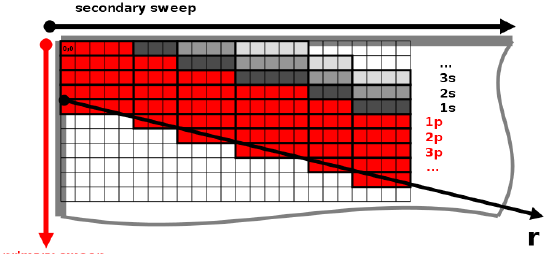
Figure 3. Truncation and shifted start of paths of the secondary sweep (shades of gray) of direction r ensures the proper alignment to the paths of the primary sweep